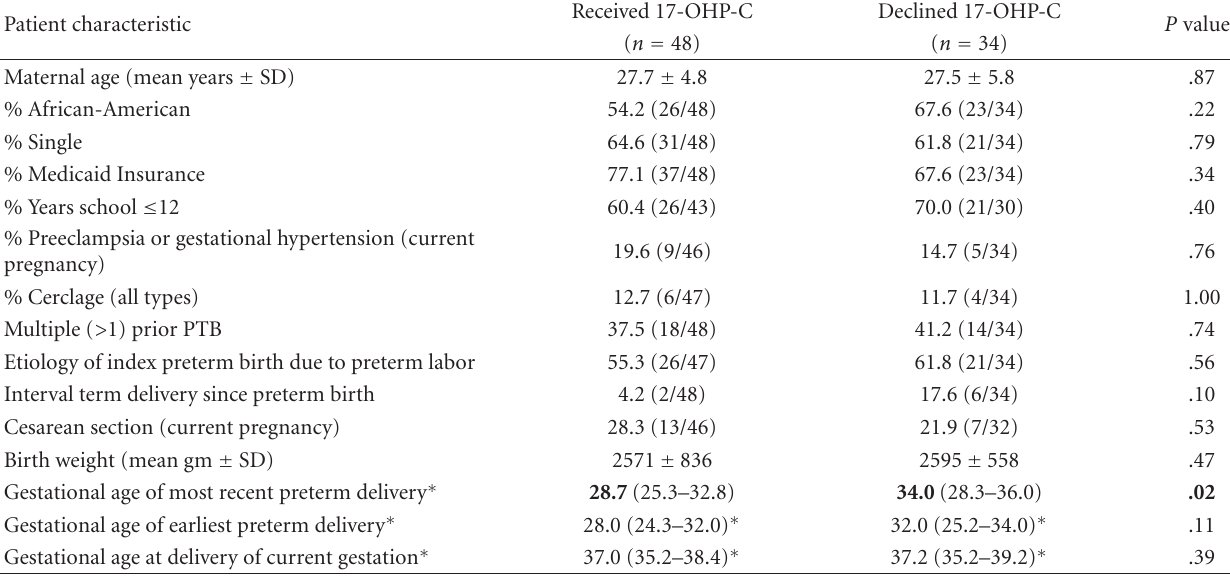
Table 2: Demographic and clinical characteristics of subjects o ff ered 17-Hydroxyprogesterone caproate (17-OHP-C). Patient